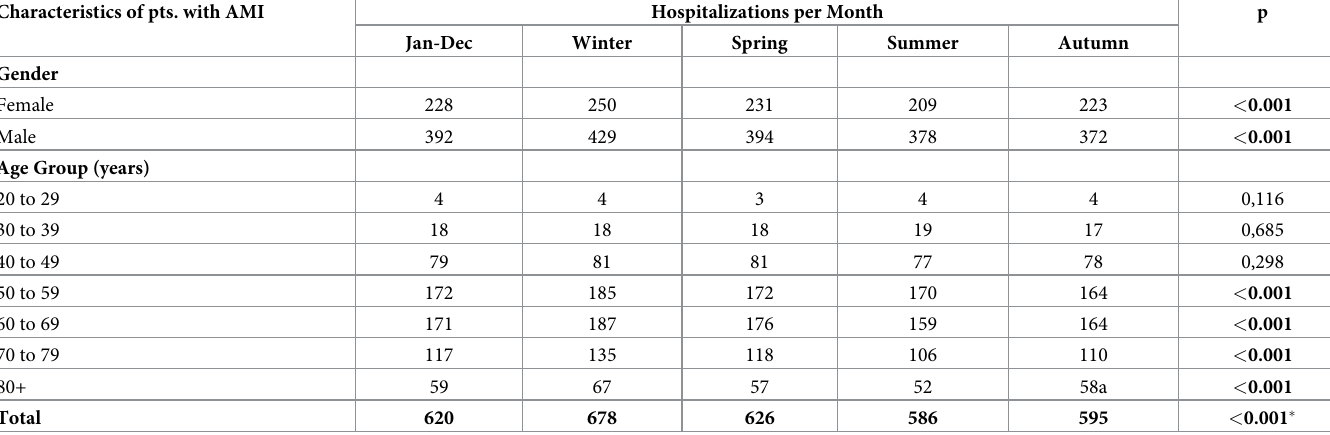
Table 2. Average number of hospitalizations per month for acute myocardial infarction, per season, according to gender and age group. Characteristics of pts. with